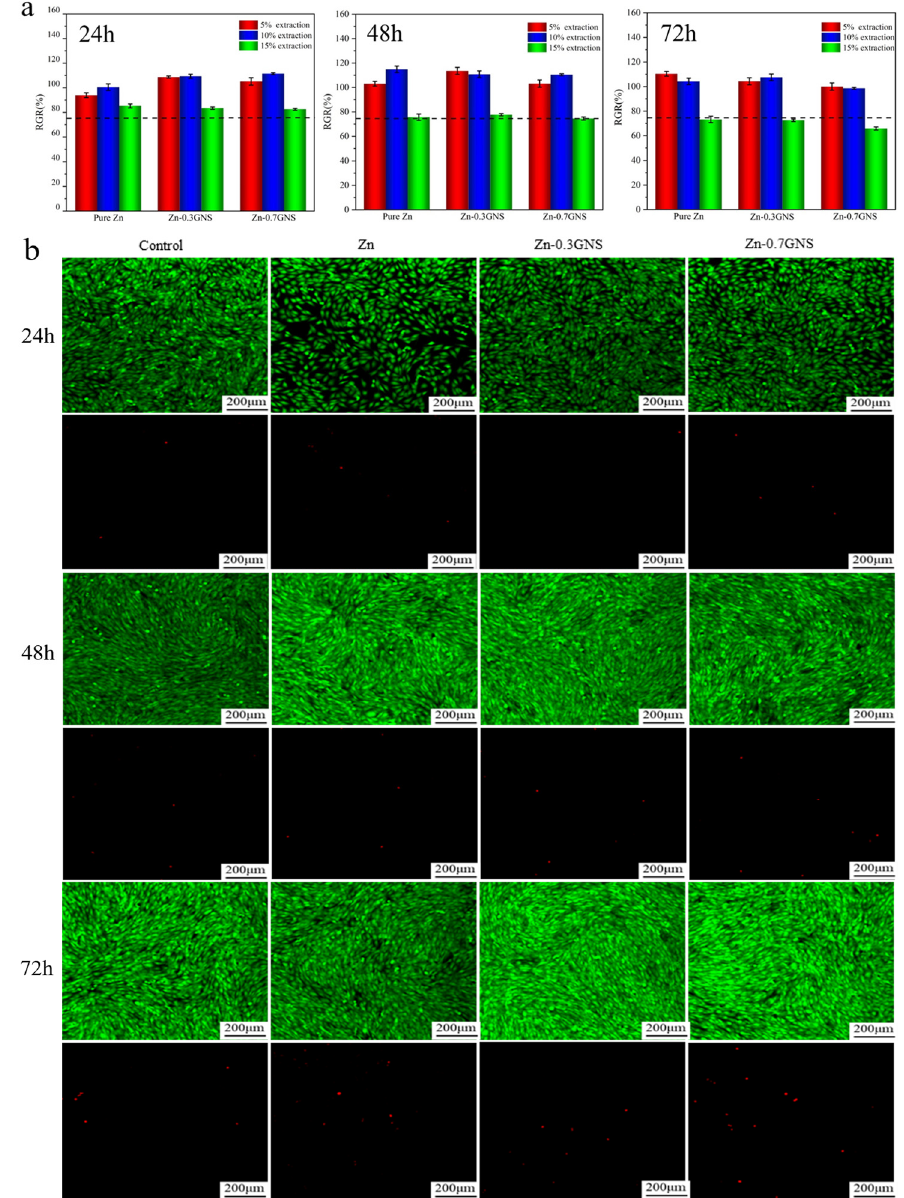
Figure 1. Cytocompatibility of pure Zn and Zn-GNS composites. ( a ) relative activity of cells; ( b ) morphology of MG-63 cells cultured in 5% extract for 24 h, 48 h and 72 h. Green represents living cells and red represents dead cells.